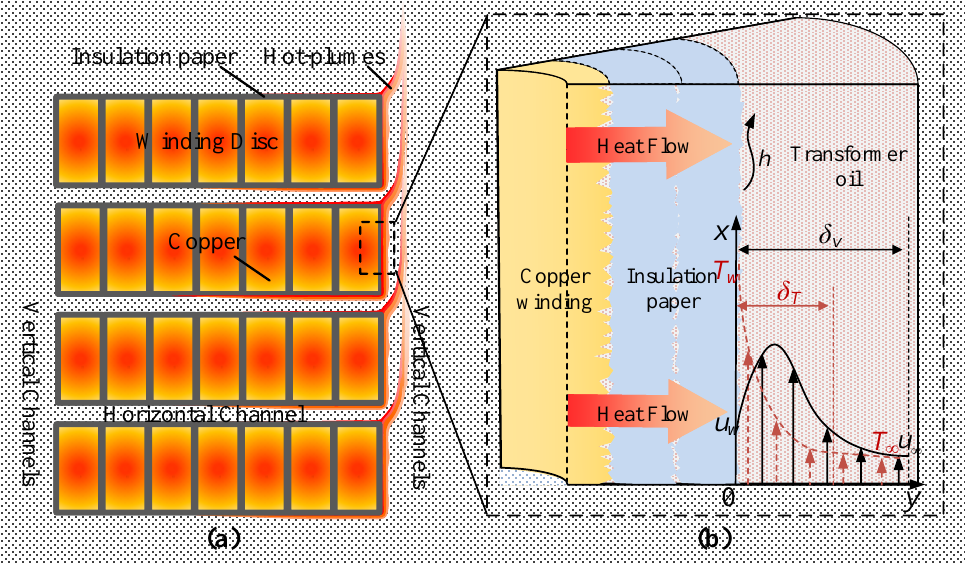
Figure 3. Heat dissipation process of transformer winding: ( a ) microscopic morphology of natural convective heat transfer boundary layer; ( b ) thermal boundary layer and velocity boundary